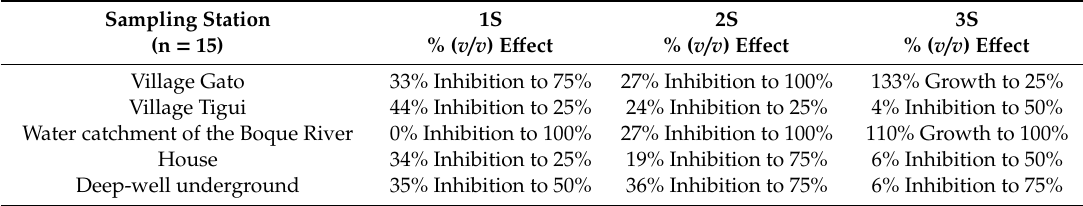
Table 1. Bioassays results with Lactuca sativa.